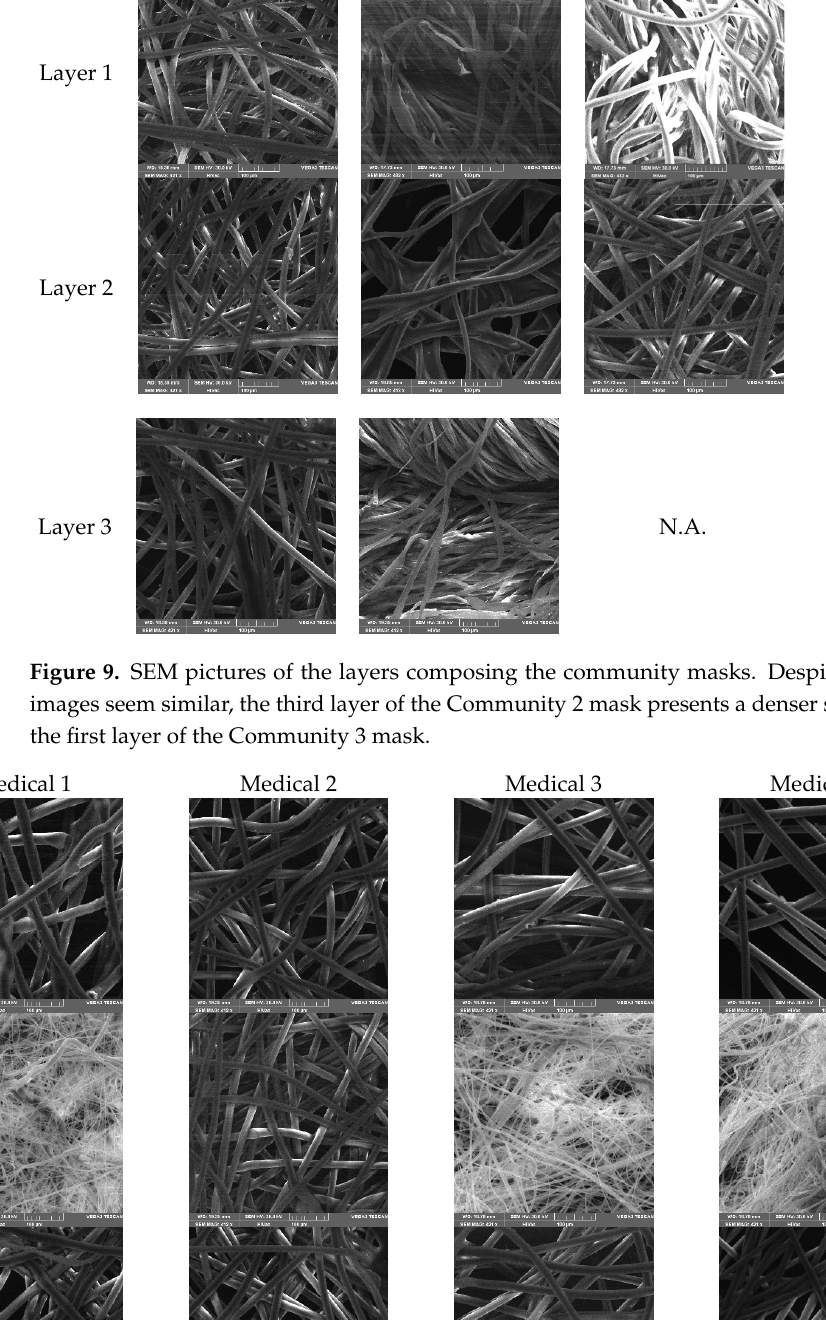
11 Figure 8. 1/3 octave spectrua of the acoustic pressure for the different mask types: community masks